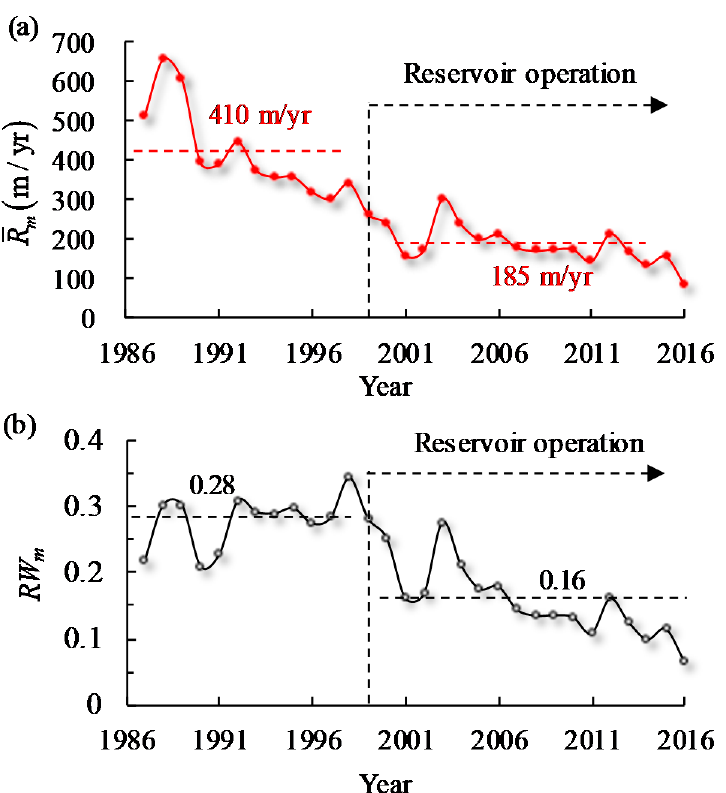
Figure 11. Temporal variations in the reach-scale channel migration parameters of: ( a ) rate; ( b ) intensity.